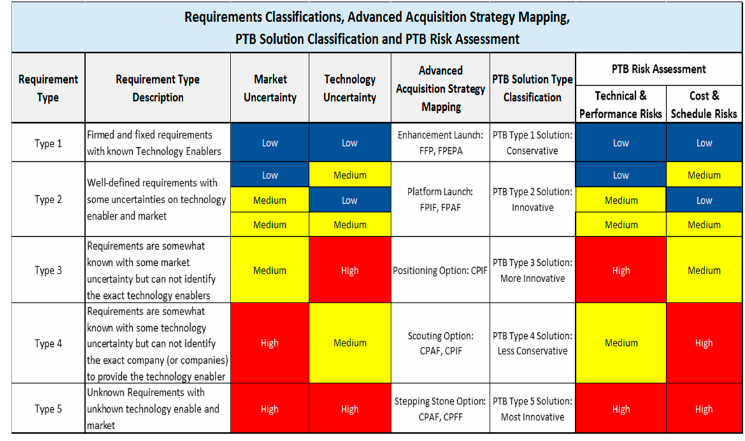
Figure 5. PTB Mapping Framework: Requirement Type-Acquisition Strategy Mapping [6,7].